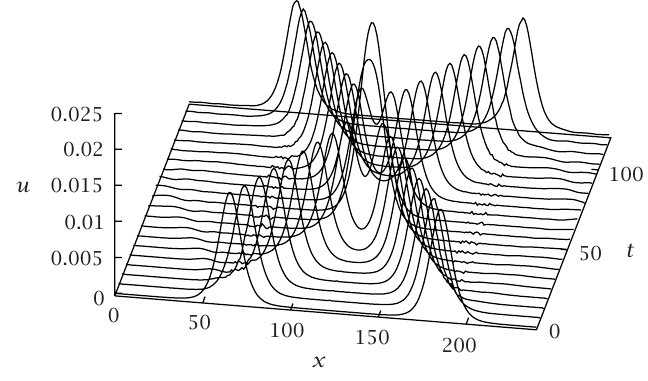
Figure 5.2. Numerical solutions for equal-amplitude solitary waves.